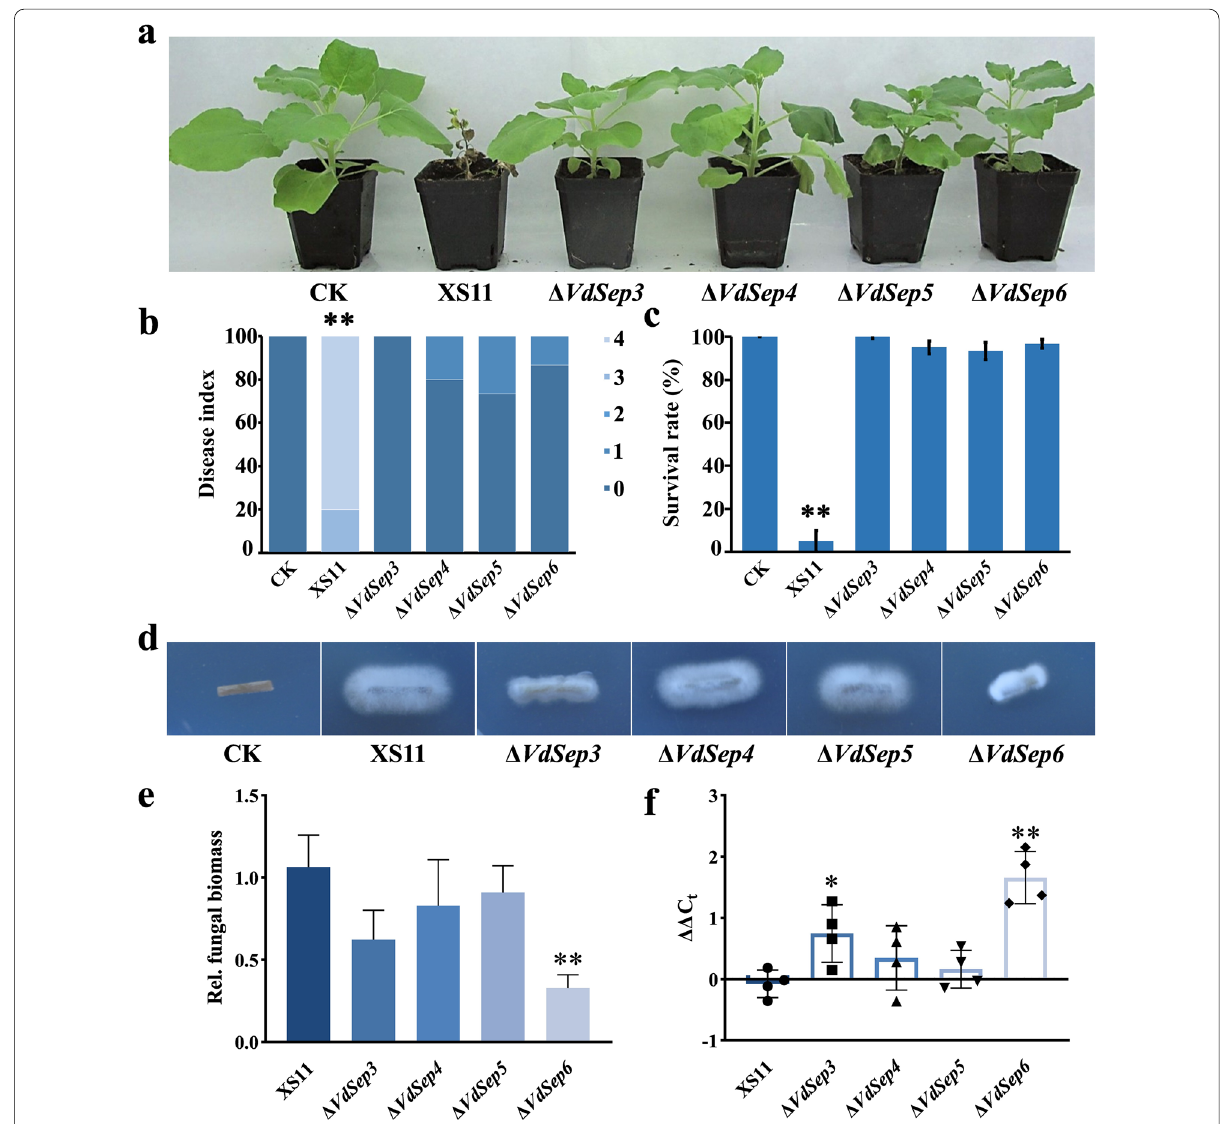
Fig. 4 The septin genes are required for the full virulence. a Symptom phenotype on Nicotiana benthamiana . One-month-old tobacco seedlings were immersed in conidial suspension (10 6 conidia/mL) of each strain for 10 min. Sterile distilled water was used as control (CK). After inoculation, all seedlings were replanted in soil and incubated in a greenhouse for 35 days at 25 °C. b Column diagram showing disease index at 35 days post-inoculation (dpi). The disease was scored on a scale of 0–4. 0, no wilting; 1, yellowing or wilting of < 2 leaves; 2, yellowing or wilting of one-fourth leaves; 3, yellowing or wilting of two-thirds leaves; and 4, more than 85% of the leaves wilted or the whole plant died. Bars represent the percentages of plants under each scale. The experiments were repeated three times with similar results (**, P < 0.01). c Column diagram showing survival rates of tobacco plants. The data were determined at 35 dpi. Error bars represent standard deviation based on three independent experiment replicates (**, P < 0.01). d Detection of the pathogen at the stem-root junction of inoculated plants at 35 dpi. e Fungal biomass detected by qRCR at 5 dpi. Error bars represent standard deviation based on four independent technical replicates (**, P < 0.01). f The ΔΔCt values of qPCR. Error bars represent standard deviation based on four independent technical replicates (**, P < 0.01; *, P <